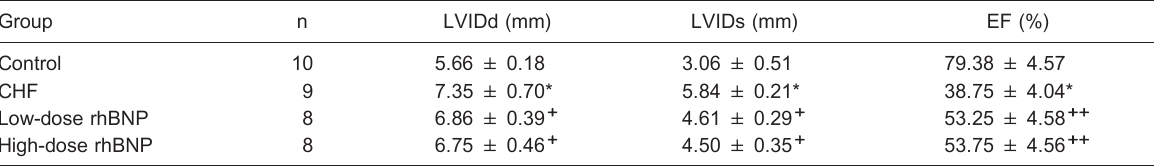
Table 1. Comparison of the echocardiographic parameters.